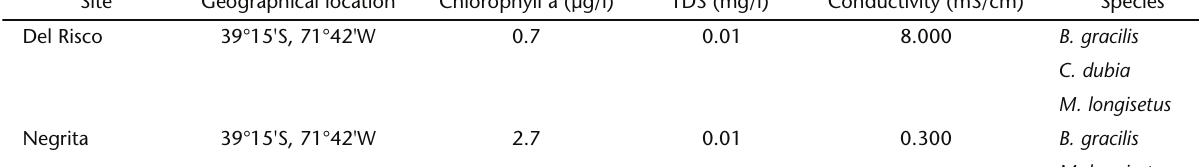
Table I. Geographical location, chlorophyll “a” concentration, total dissolved solids, conductivity and crustacean species reported for the studied sites.